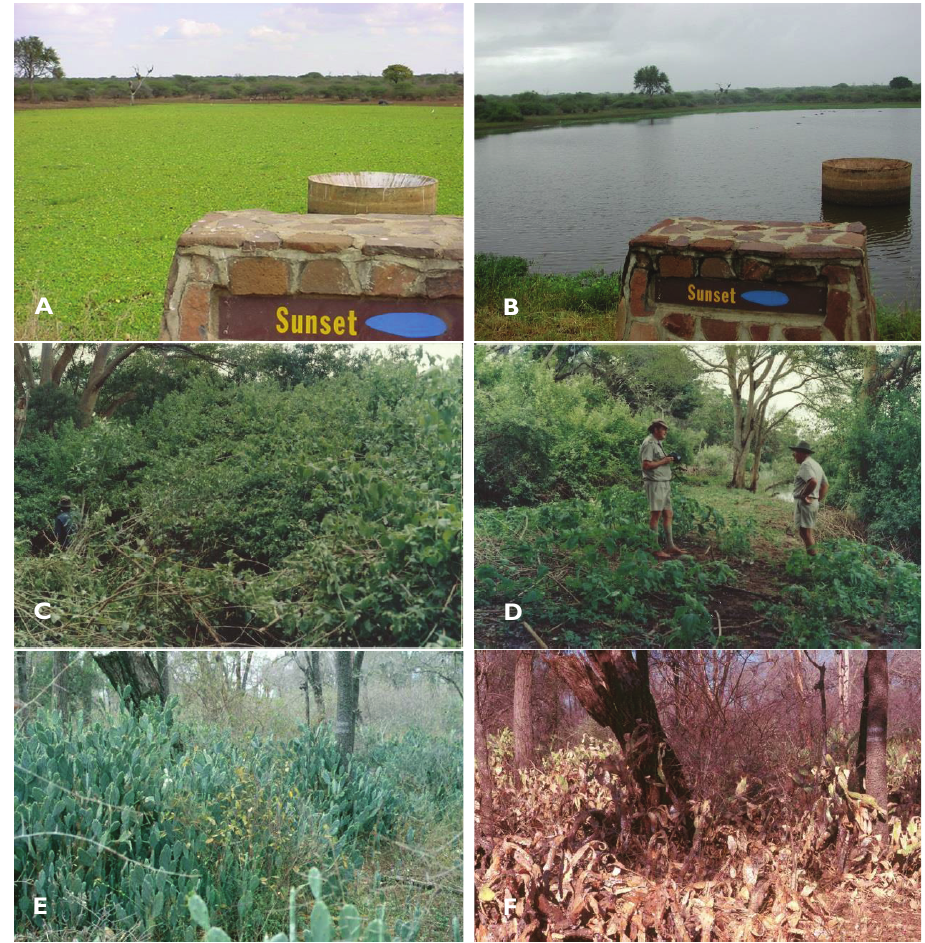
Figure 2. Before and after control of alien plant species in Kruger National Park, South Africa. Sunset Dam was heavily infested by Pistia stratiotes ( A ), which was effectively eliminated by a combination of biological and chemical control ( B ). Dense invasions of Lantana camara along the Sabie River ( C ) have required intensive mechanical and chemical control to clear ( D ). Populations of Opuntia stricta ( E ) have been effectively reduced to low numbers with biological control ( F